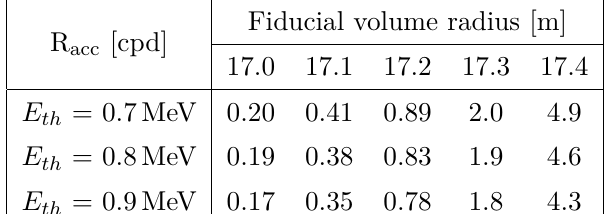
Table 5. Evolution of the accidental rate R acc with FV and energy threshold cuts. An accidental background rate of 0.89 cpd is expected with default cut values E r LS = 17.2 m, and with ∆ T p − d coincindence window and D p − d upper distance fixed at 1 ms and 1.5 m,